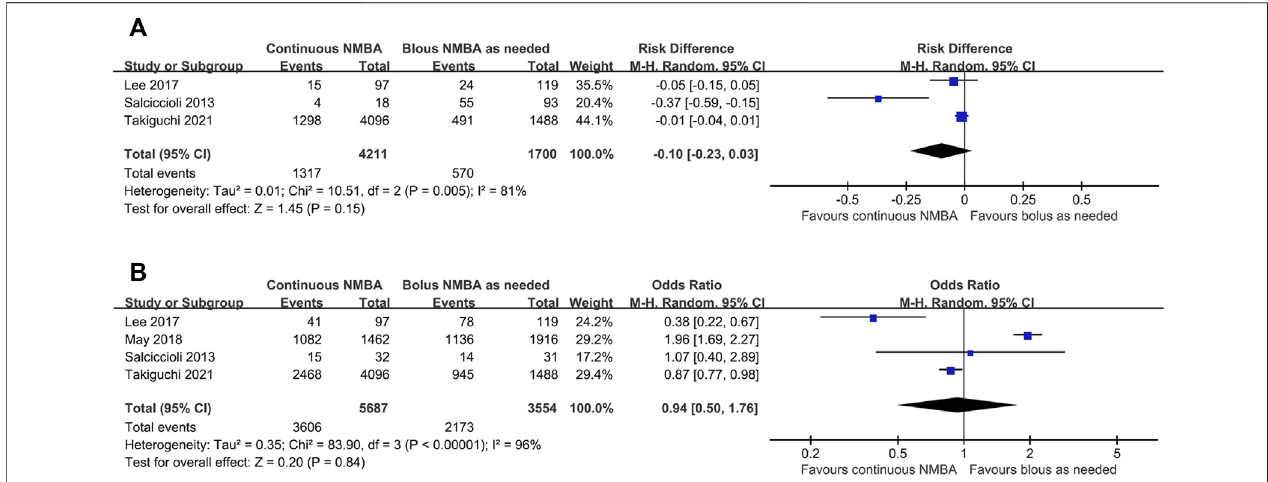
FIGURE 2 | Forest plot of comparing prophylactic neuromuscular-blocking agent to without neuromuscular-blocking agent regimen in outcomes of mortality.